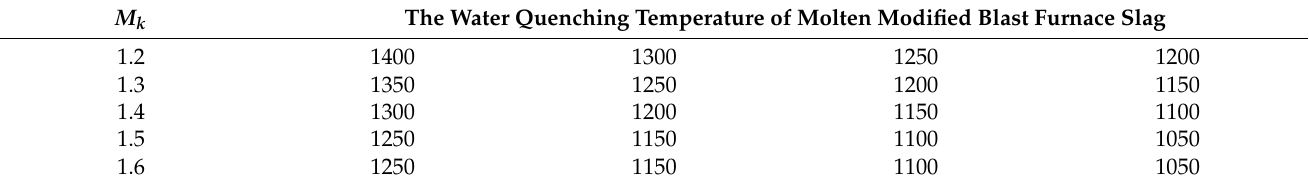
Table 4. The water-quenching temperature of molten modified blast furnace slag with different M k /°C.